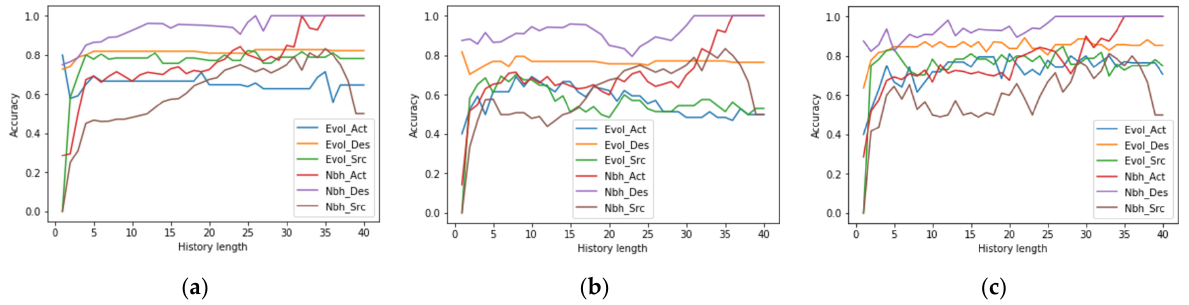
Figure 7. Sequence length evaluation based on APT ‐ S ‐ 1. ( a ) CCR. ( b ) TE. ( c ) Proposed.